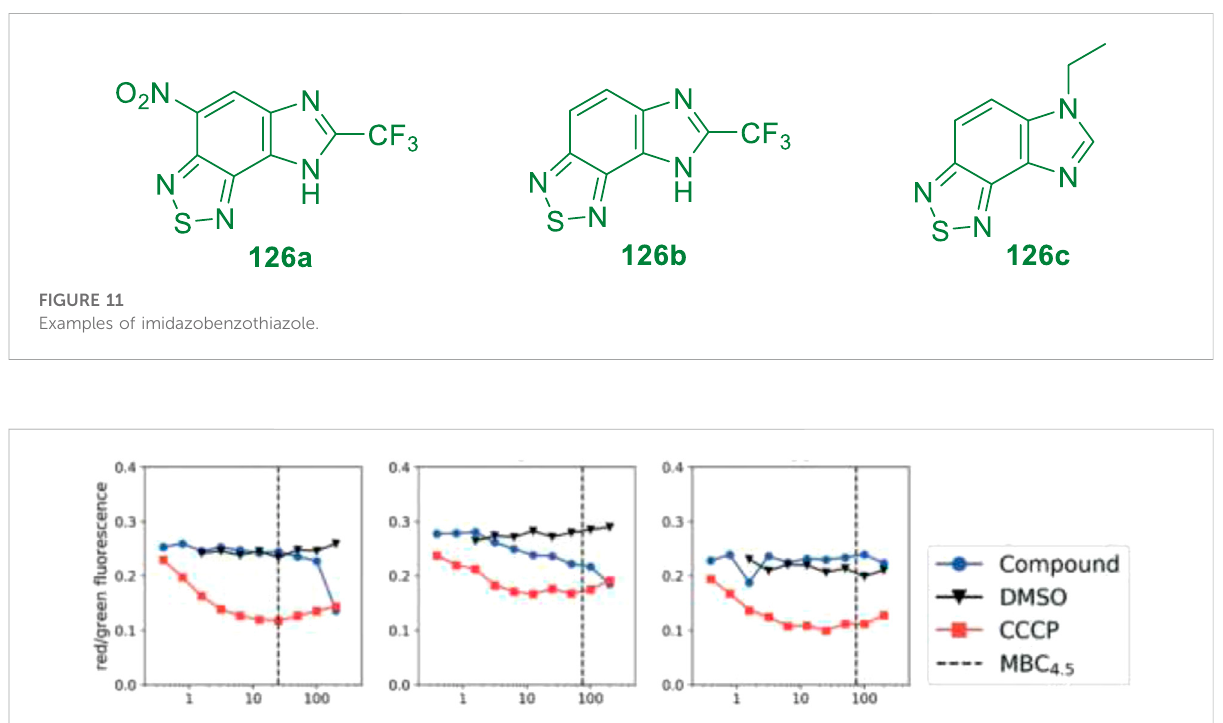
FIGURE 12 M. tb membrane potential disruption at pH 6.8 by benzothiadiazole analogs. Reproduced from Smith et al., 2019, with permission from Royal Society of Chemistry, Copyright